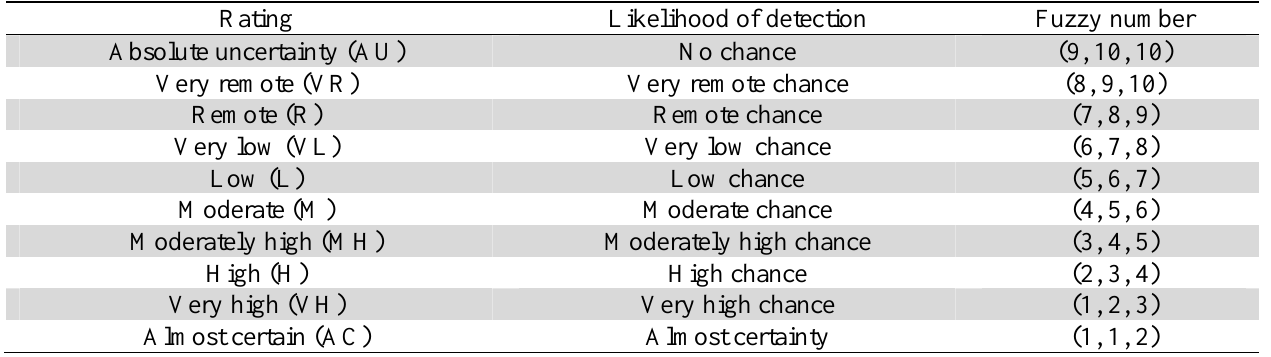
Fuzzy ratings for detection of a failure (Chin et al., 2008; Wang et al., 2009)